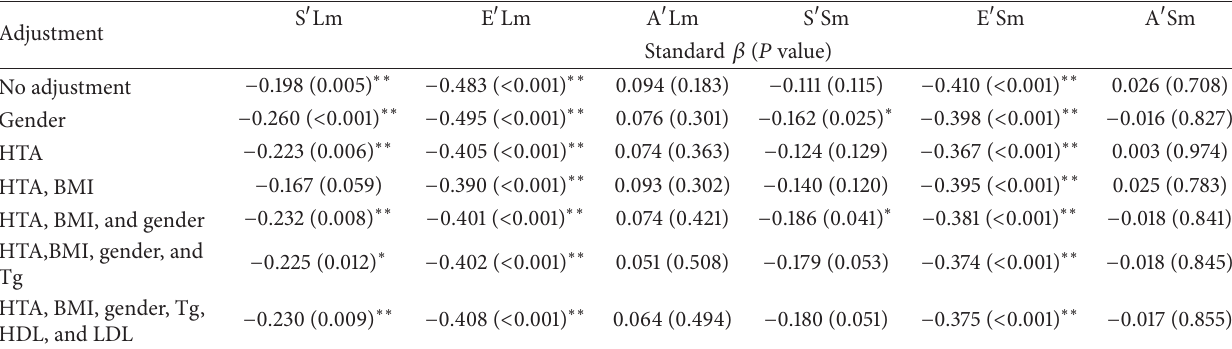
Table 5: Multivariate regression analysis for tissue Doppler LV